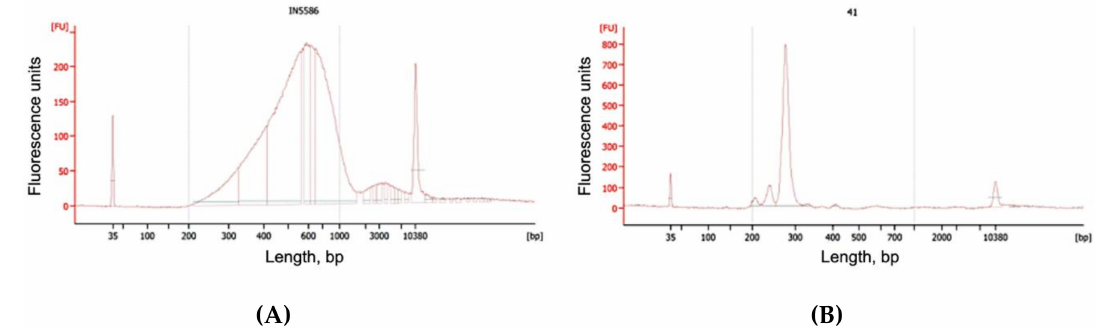
Figure 2. Electrophoregrams (Bioanalyzer 2100, Agilent) of chimeric DNA libraries: “smash” ( A ) and fetal fraction estimation library—“amplifet” ( B